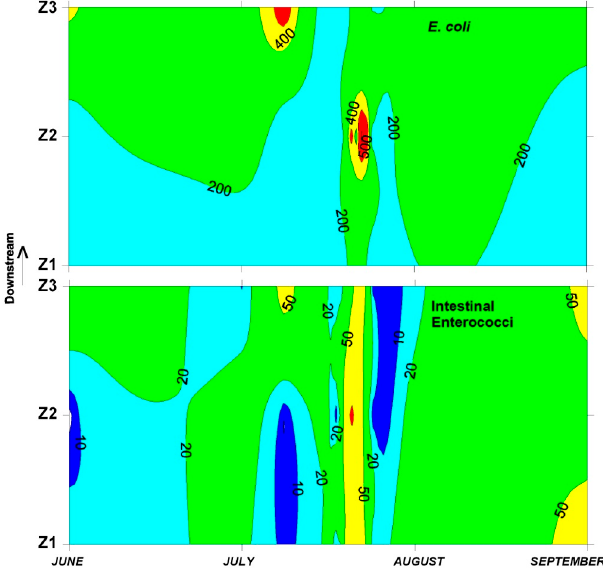
Figure 3. Spatial (Z1 through Z3) and temporal (June through September) distribution of E. coli and intestinal enterococci (cfu per 100 mL).